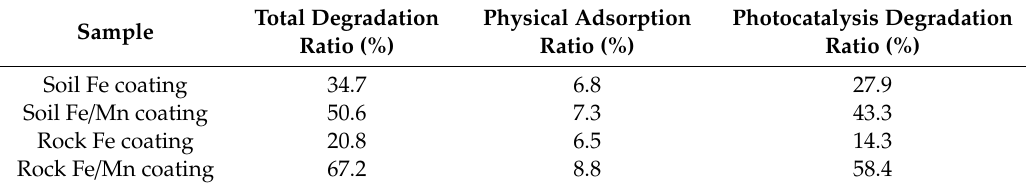
Figure 12. Curves of MO (methyl orange) degradation by the soil Fe coating ( a ), soil Fe / Mn coating ( b ), rock Fe coating ( c ) and rock Fe / Mn coating ( d ) under light irradiation. Table 1. MO degradation performance of different natural ferromanganese coatings.